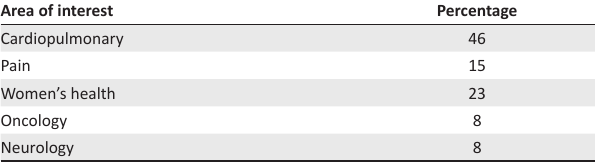
TABLE 3: Areas of interest expressed by participants of the focus group